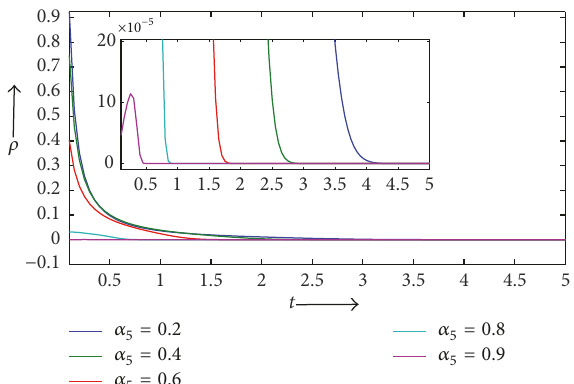
Figure 21: Variation of energy density 𝜌 against time for 𝛼 1 = 0.5 , 𝜔 = 1 , 𝜙 0 = 1 , 𝑐 2 = 0.1 , and different 𝛼 5